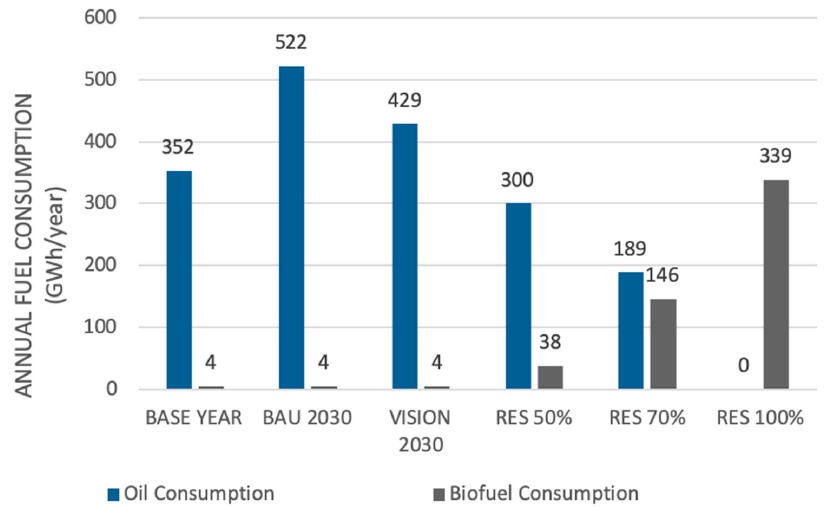
Figure 12. Annual fuel consumption (GWh/year) for base year 2019 and five scenarios by 2030 in Isla de la Juventud.